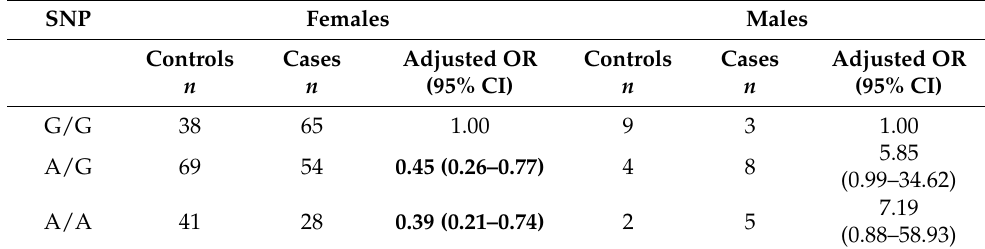
Table 4. Stratified analysis by sex for genotype frequencies between cases and controls.